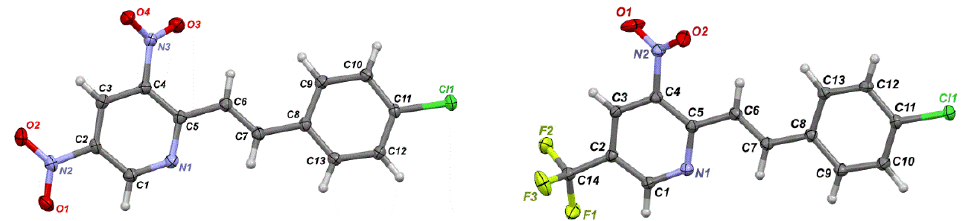
Figure 2. X-ray crystal structures of compounds 4a (left) and 4i (right) with thermal ellipsoids at 50% probability level.